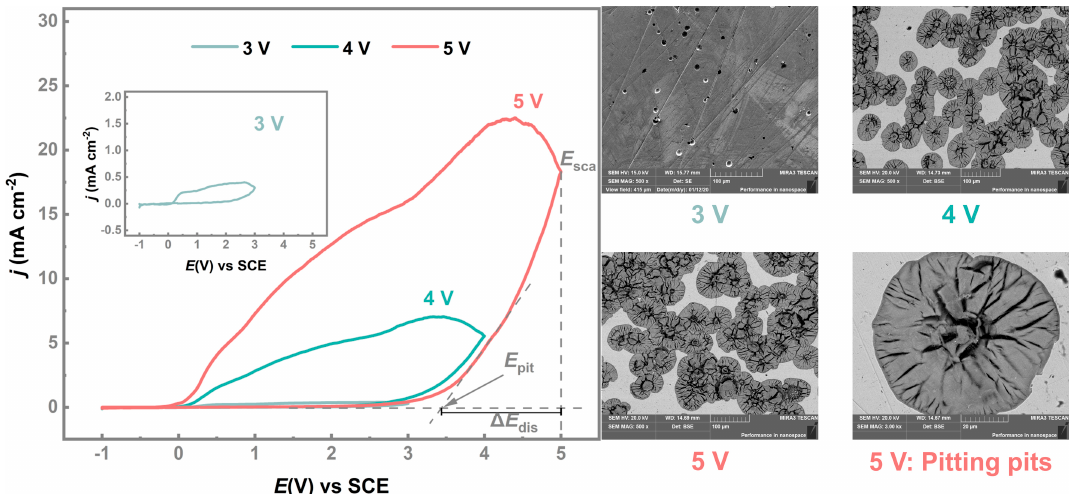
Figure 3. Cyclic voltammetry curves and SEM observation on anodic Hf corrosion in the Et 4 NCl- based anhydrous ethanol system. Condition: on Hf in the ethanol and acetonitrile ( V / V = 1:1) solu- tion containing 0.06 M Et 4 NCl at different potentials, 30 °C and a scanning rate of 1 mV/s. SEM images were obtained by chronoamperometry at different potentials for 100 s. Δ E dis = E sca − E pit .